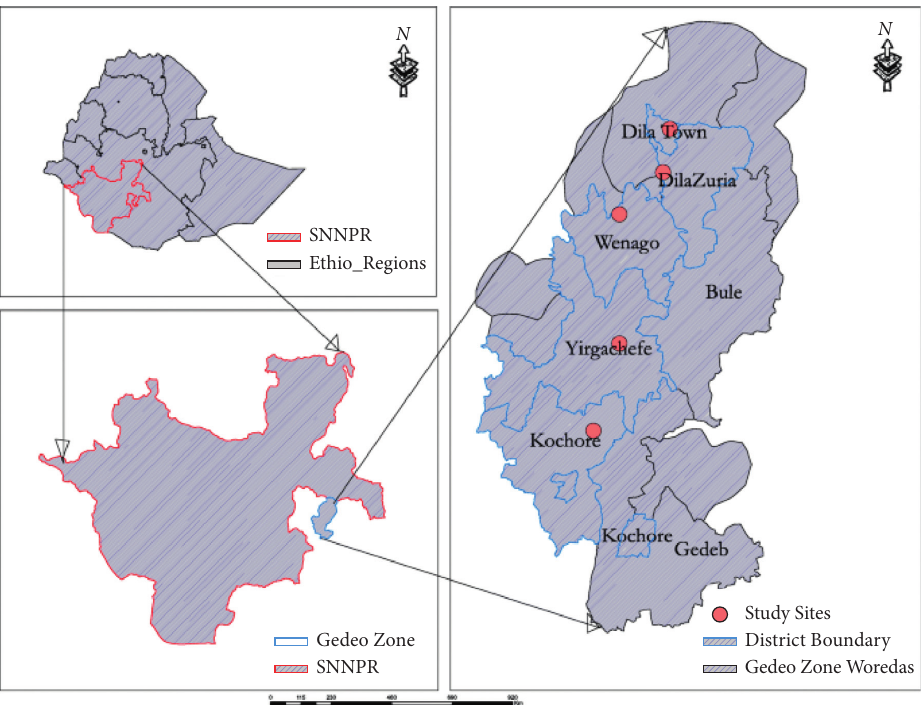
Figure 1: Map of Gedeo